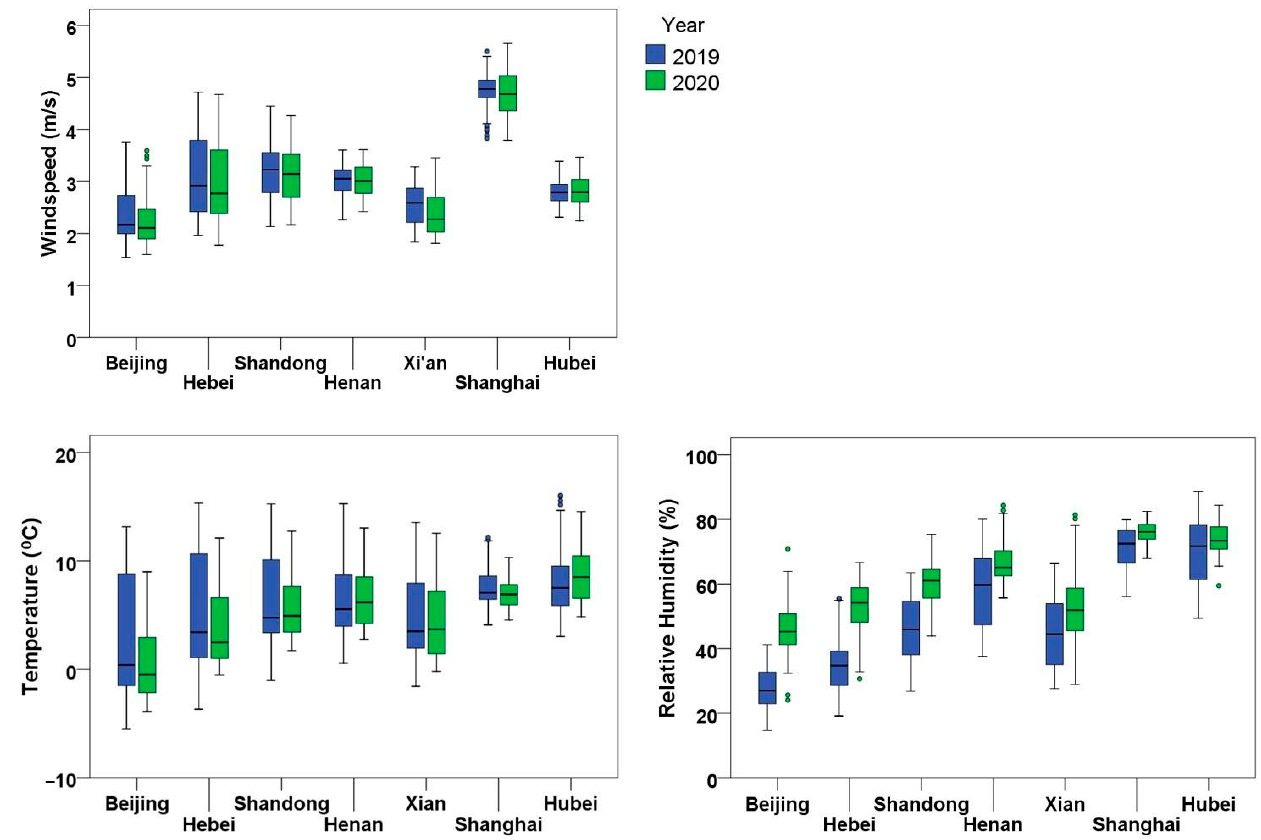
Figure 4. Mean daily wind speed, relative humidity and temperature for the 91-day period of analysis for 2019 and 2020 across seven study regions of China.